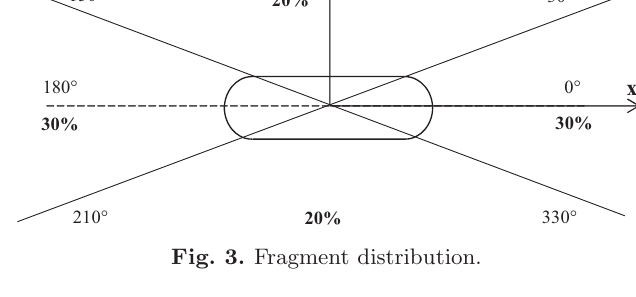
Fig. 1. Explosion generates fragment series.